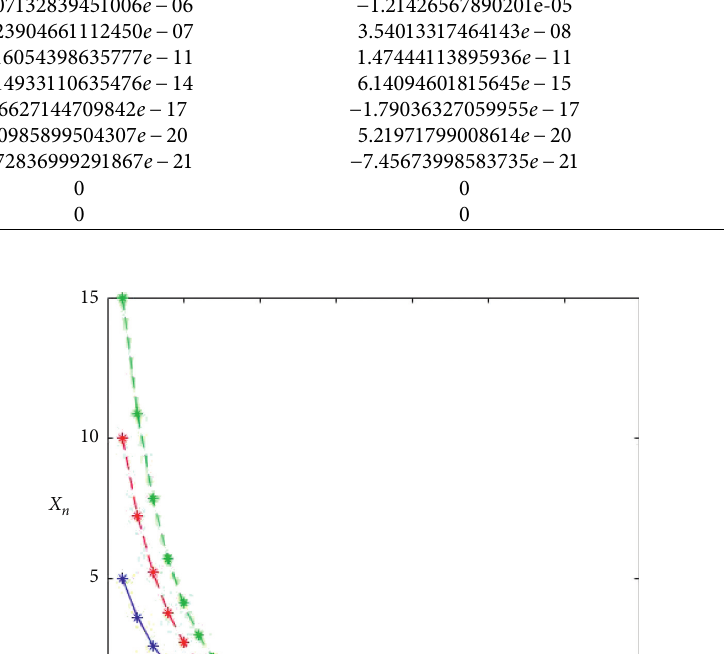
� 5, x � 10, and x 0 0